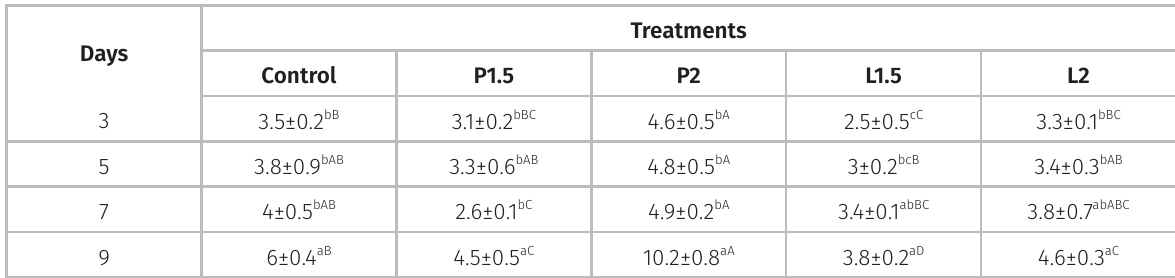
Table I. Mass loss (%) of minimally processed papaya, uncoated and coated, storage at 5 °C for 9 days.